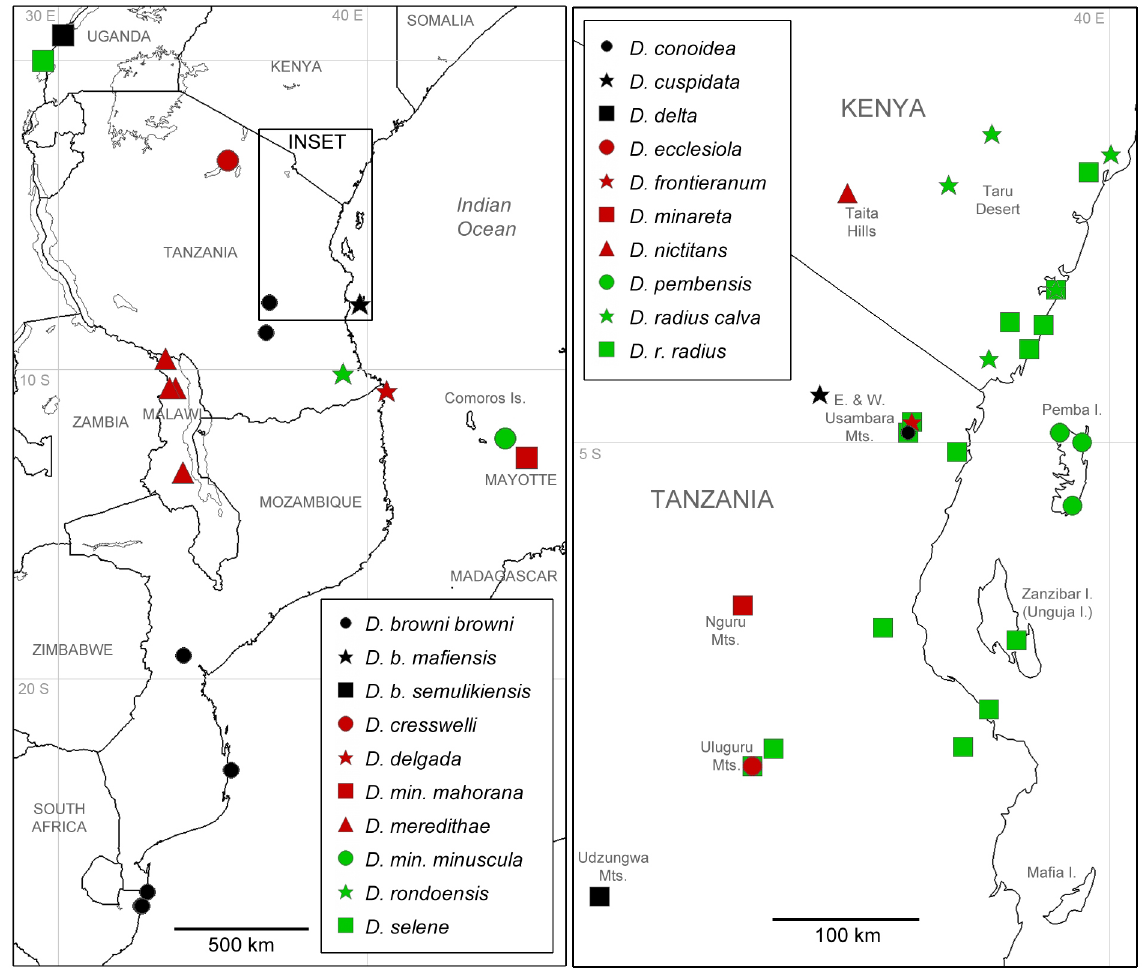
Fig. 84. Distribution of Dadagulella gen. nov. species, based on published records and material examined here (for additional records of D. meredithae comb. nov. in northern Malawi see van Bruggen 2000). The inset on the left corresponds to the map on the